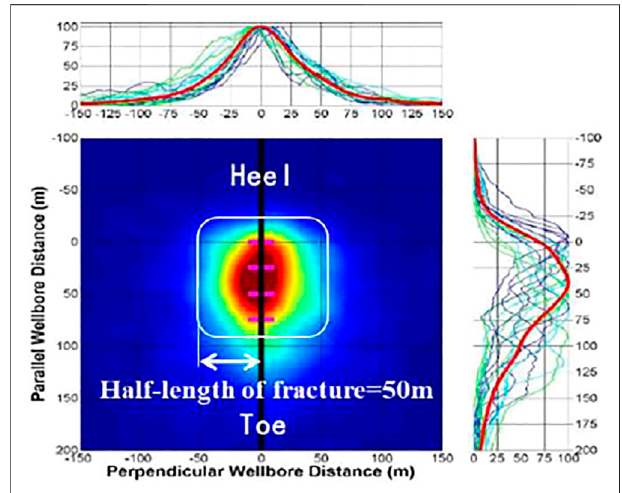
FIGURE 4 | Microseismic interpretation